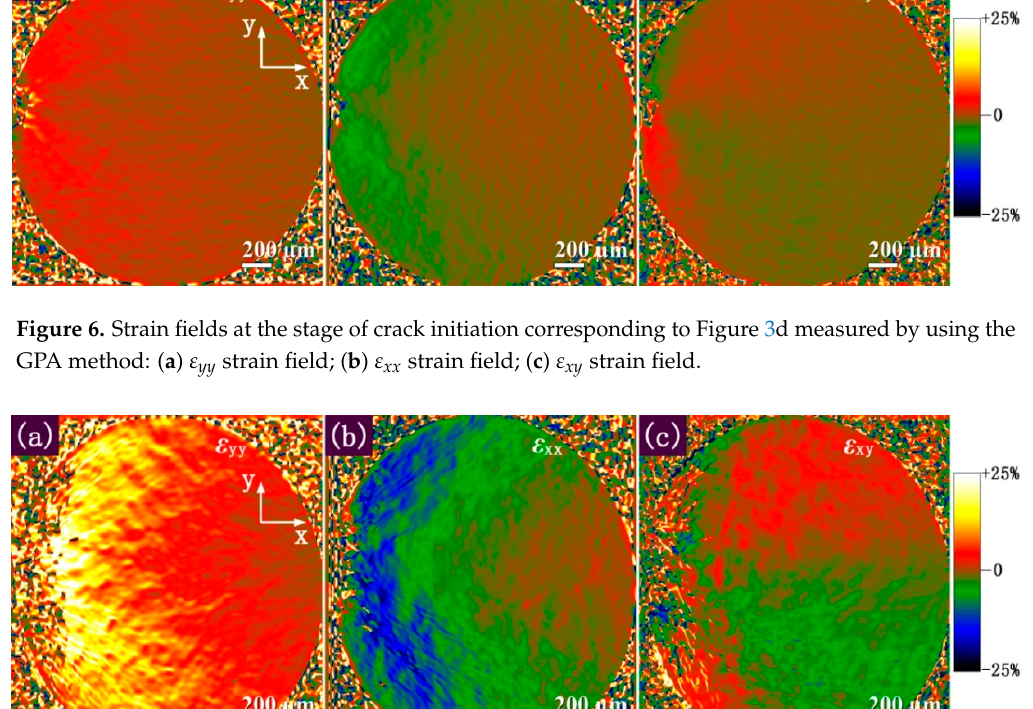
Figure 6. Strain fields at the stage of crack initiation corresponding to Figure 3d measured by using the GPA method: ( a ) ε yy strain field; ( b ) ε xx strain field; ( c ) ε xy strain field.